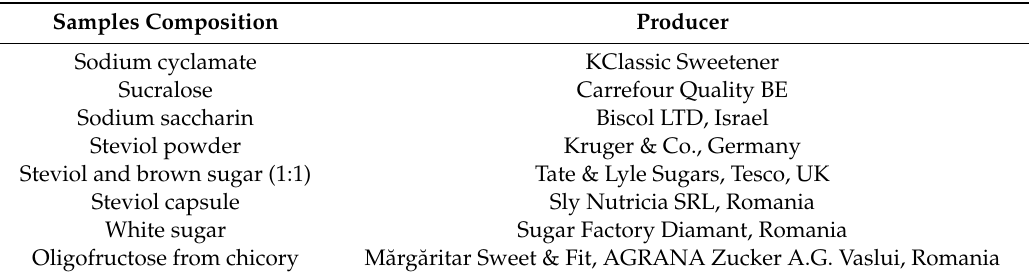
Table 1. Sample presentation and composition of the